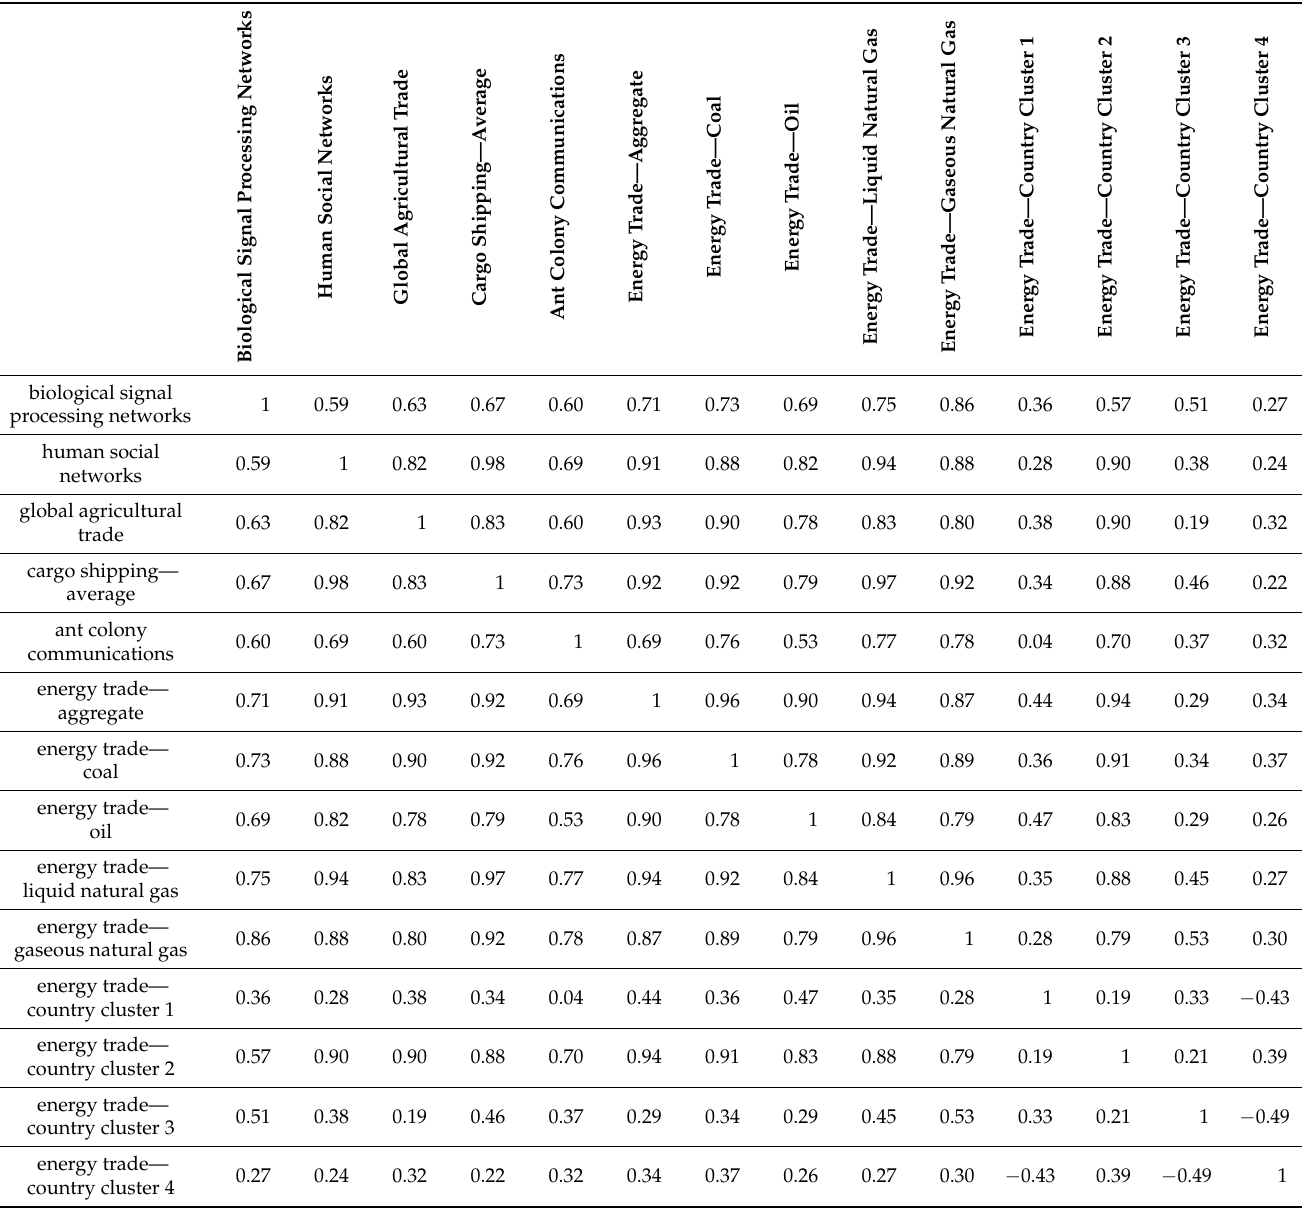
Table 2. Pearson correlation coefficients between all networks examined in this